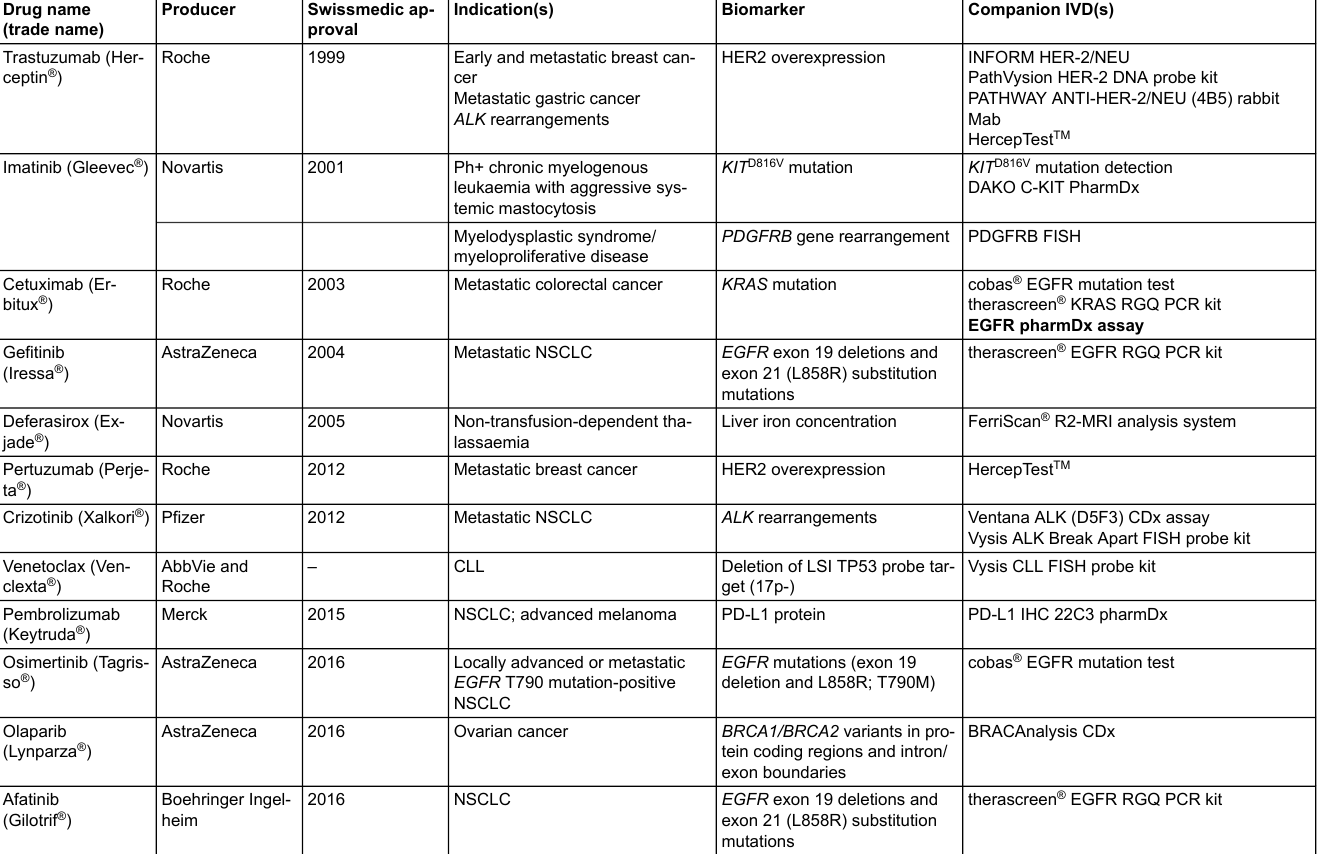
Table 1: Overview of selected compounds and their companion diagnostics in and beyond the field of oncology. Drug name (trade name)